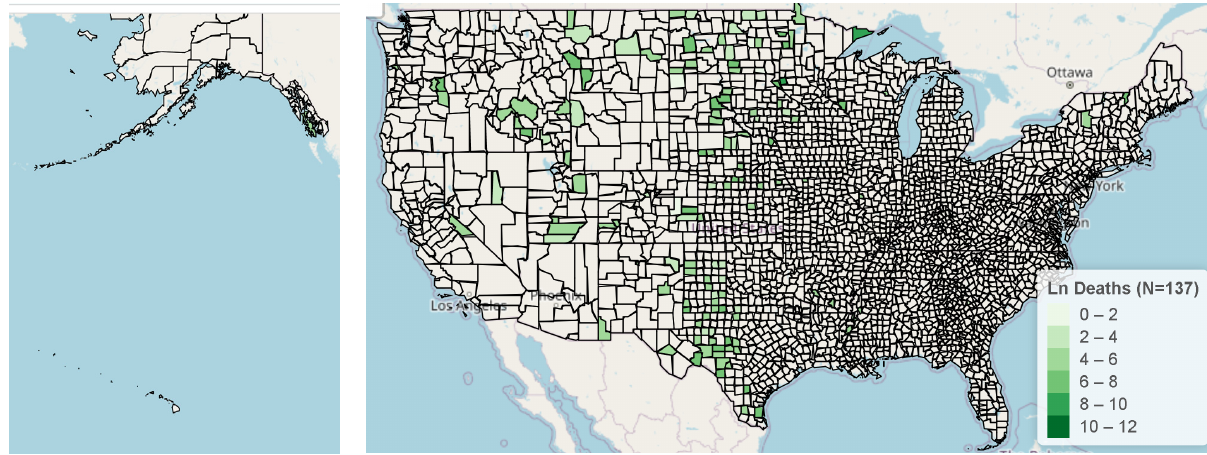
Figure 3. Counties where the mean is greater than the